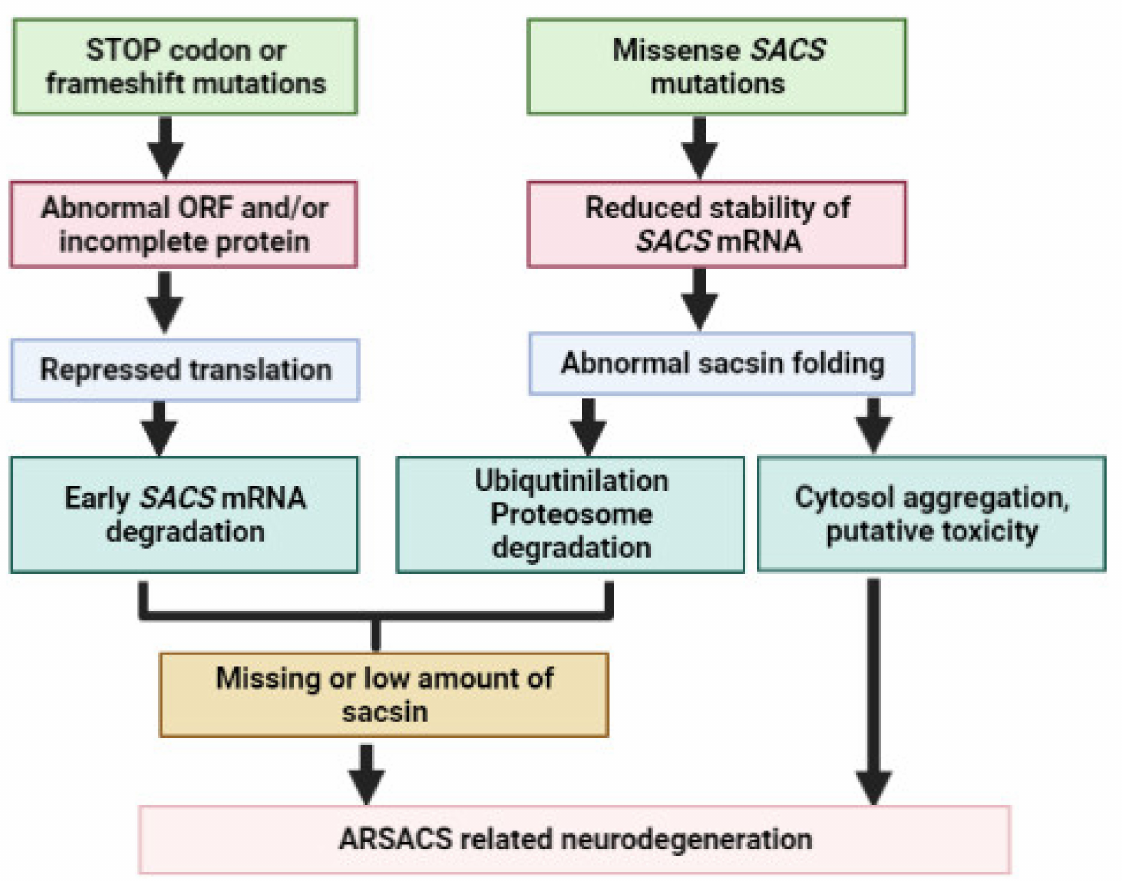
Figure 4. Potential effects of mutations in SACS